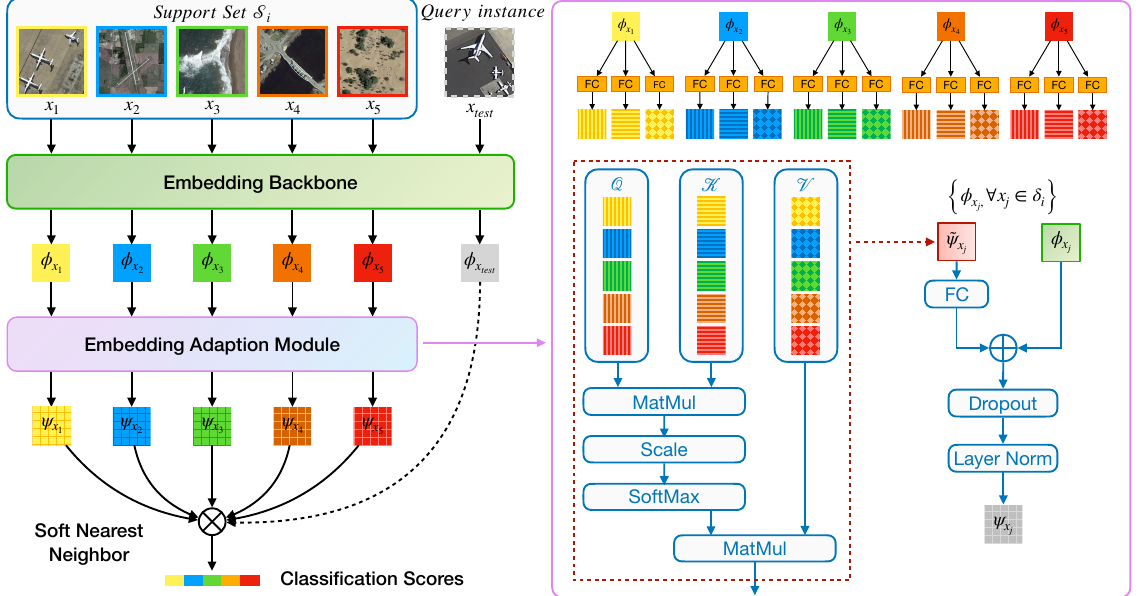
Figure 5. Illustration of the structure of our embedding adaption module, implemented with a set-to-set function based on Transformer. The right part shows the adaption step that transforms the embedding f φ ( x ) to f ψ ( x ) . For notational simplicity, we use φ x and ψ x instead of f φ ( x ) and f ψ ( x ) in the figure,